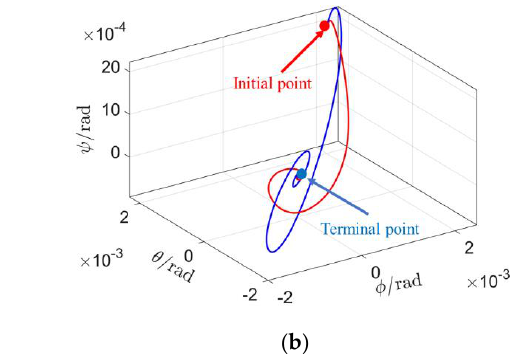
Figure 8. Trajectories of the position and attitude of the test mass with the RobCA method and the PICA method. ( a ) Position trajectories. ( b ) Attitude trajectories. The comparison of the nearest distance between the test mass and the electrode house along x , y , z axis with the RobCA method and the PICA method are presented in Figure